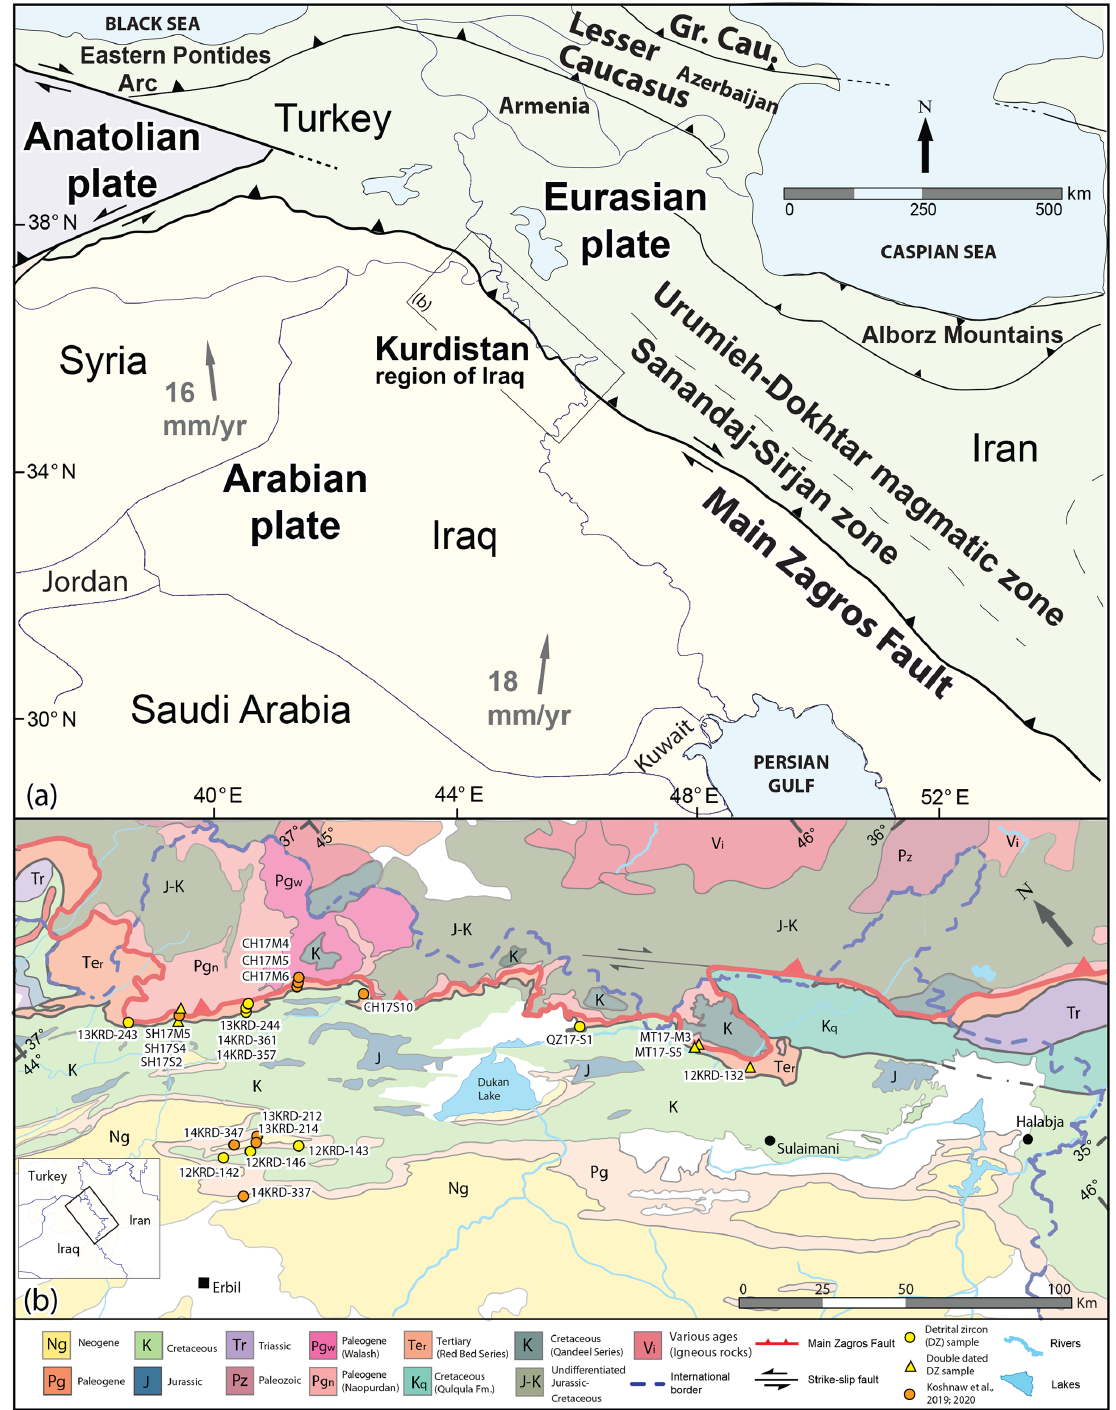
Figure 1. (a) Regional tectonic map of the Middle East displaying the study area in the Kurdistan region of Iraq, and the suture of the Arabian and Eurasian plates along the Main Zagros fault (Koshnaw et al., 2017, and references therein). (b) Geologic map of the NW Zagros area in the Kurdistan region of Iraq showing new (yellow) and published (orange) sample locations (Koshnaw et al., 2019, 2020a, and references